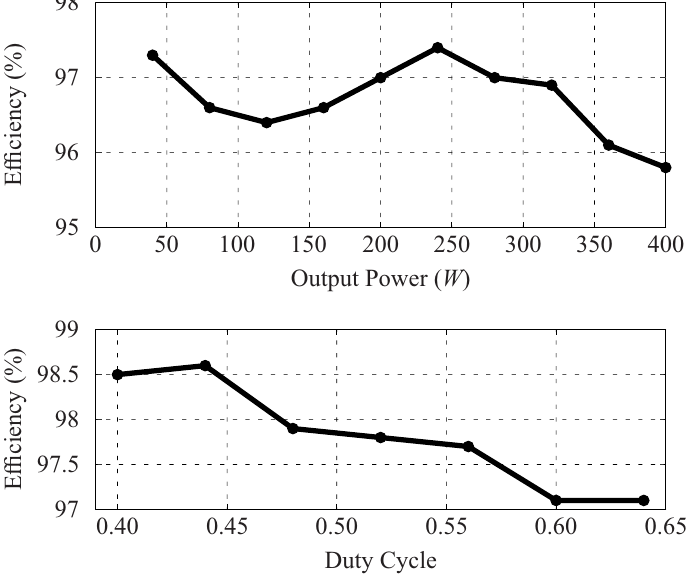
Figure 11. Efficiency tests results: different loads under constant duty cycle and 400 V output voltage, different duty cycle under constant 200 W and 400 V output